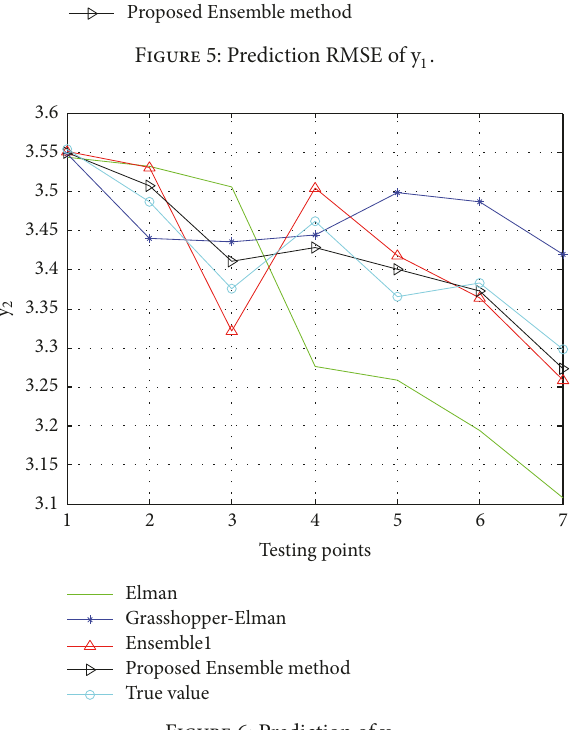
Figure 6: Prediction of y 2 .